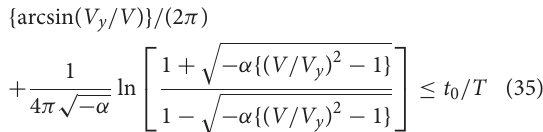
Collapse Pattern 3